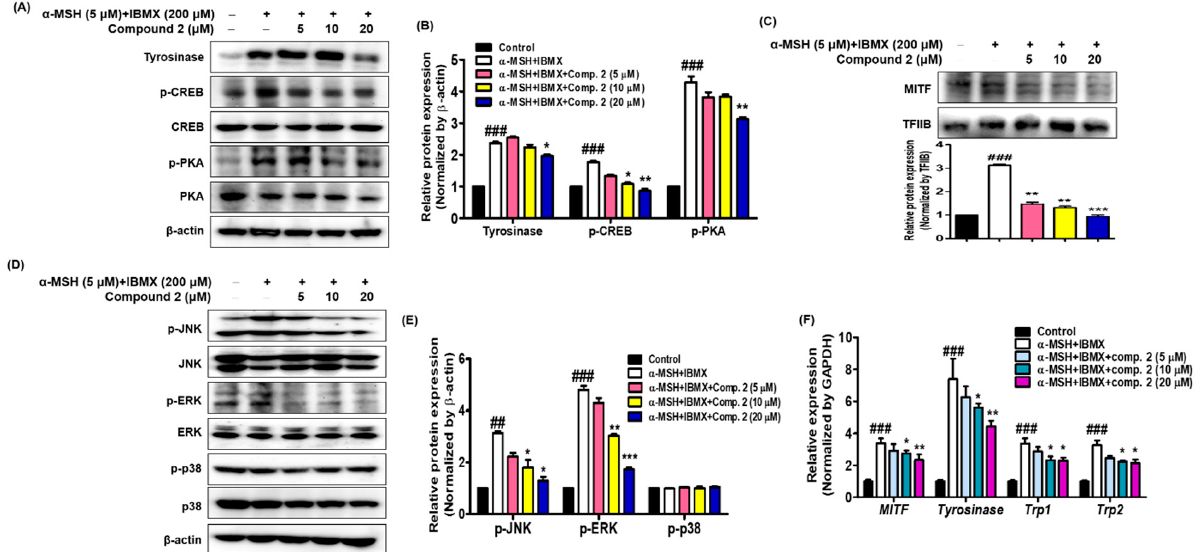
Figure 7. Effects of compound 2 on melanogenic proteins and mRNA levels in α -MSH- and IBMX-induced B16F10 cells. Cells were pre-incubated for 24 h and then stimulated with α -MSH (5 μ M) and IBMX (200 μ M) in the presence of compound 2 (5, 10, and 20 μ M). The expression levels of tyrosinase, p-CREB, p-PKA, p-JNK, p-ERK, p-p38, and β -actin were determined with Western blotting in the cytosolic fraction. β -actin was used as the loading control ( A , B , D , E ). The expression levels of MITF and TFIIB were determined with Western blotting in the nuclear fraction. TFIIB was used as the loading control ( C ). Relative mRNA levels of the melanogenic genes MITF , Tyrosinase , Trp1 , and Trp2 in the cells were quantified using real-time qPCR and normalized to the GAPDH mRNA level ( F ). The primer sets are shown in Table 1. Data are presented as the mean ± SEM of three independent experiments. ## p < 0.01 and ### p < 0.001 vs. control. * p < 0.05, ** p < 0.01, and *** p < 0.001 vs. α -MSH and IBMX-treated cells.